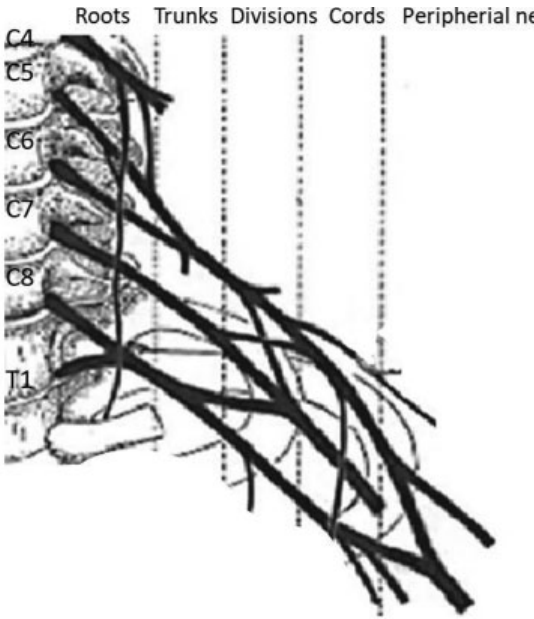
Fig. 1 Schematic diagram showing the origins of the brachial plexus.